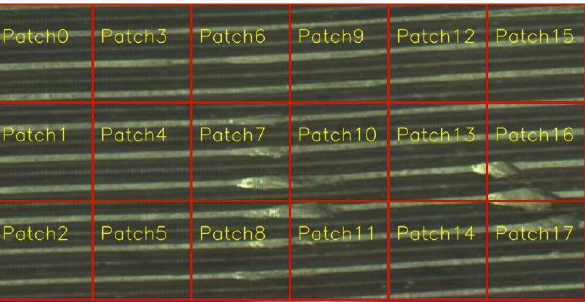
Figure 10. The slice patches of the panoramic screw image for the testing phase (unit: 0.03 mm/pixel).